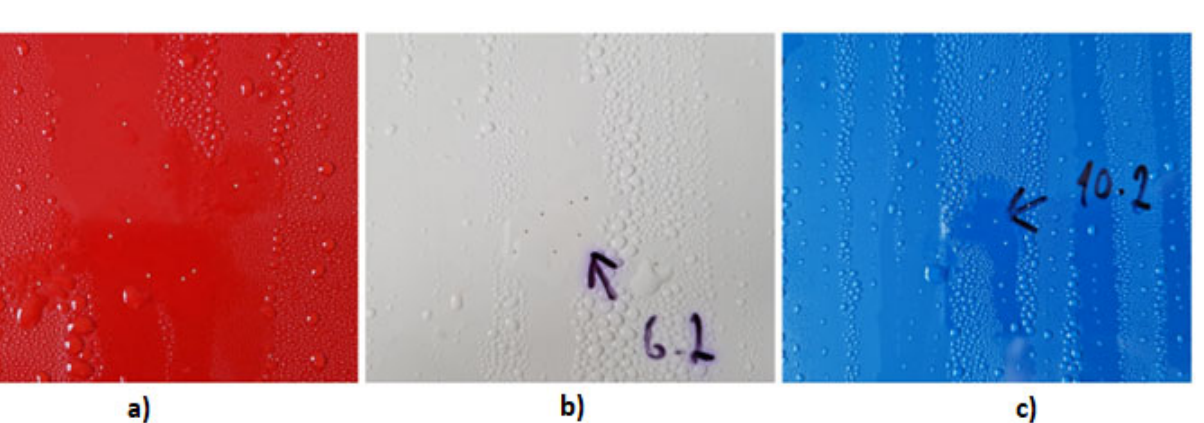
Figure 14. Sample 8 and its fatal damage. Individual observations after defined time intervals did not yield any significant changes. The only exception is sample 8, whose upper coat and primer suffered severe damage that expanded with each salt chamber interval. Evaluation of the results under the microscope was performed after the last stage, i.e., after 2 weeks in the salt chamber. 3.5. Observation of Lightning Damage Exposed to a Salt Chamber under a Microscope Samples that were exposed to the salt chamber were examined individually under a microscope. Their evaluation was carried out chronologically according to Table 3. At first glance, signs of salt chamber exposure could be observed. However, these marks were only superficial and no major damage was visible on the surface of the samples after washing. The exception is sample No 8, whose upper coat suffered destructive damage. However, these damages were not limited to the areas where the electrical discharge had hit, but extended to the surface of the entire sample. This concludes the fact that the action of the salt chamber on a given combination of top coat and primer is devastating and the use of this combination is totally inappropriate, apart from the damage caused by the lightning. Closer examination under the microscope clarified that the salt chamber, similar to the naked eye observation, did not cause any damage that would significantly affect the difference between lightning strike damage and subsequent exposure to external conditions. The only exception is the aforementioned sample 8, the microscope view of which is shown in Figure 15.